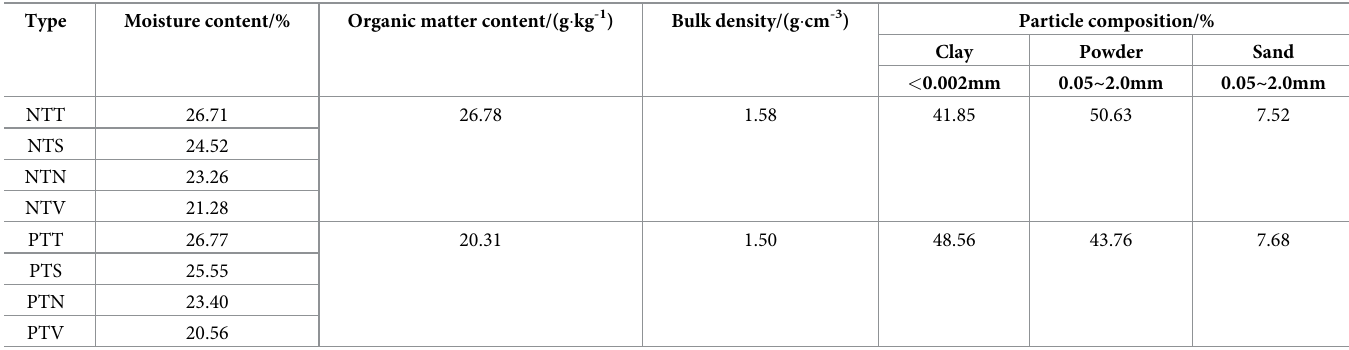
Table 1. Basic soil physical properties.